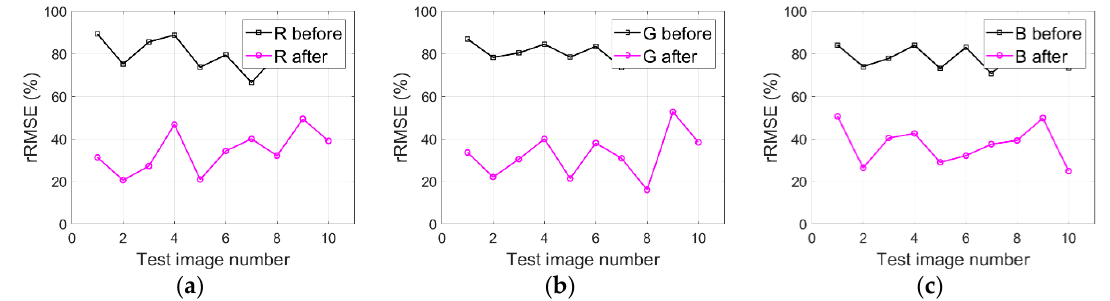
Figure 16. IRB method generalization analysis for WV3-Tripoli images in terms of R, G, and B components. ( a ) R. ( b ) G. ( c ) B.